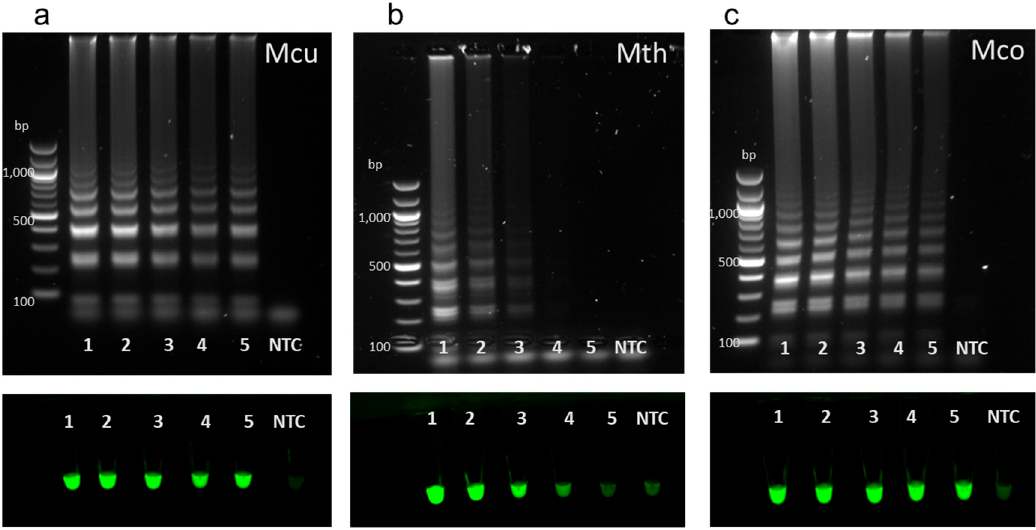
Figure 6. LAMP assay outputs comparing agarose gel electrophoresis (top panels) and Sybr Green I end-point detection (bottom panels). Genomic DNA from ( a ) Methanoculleus marisnigri JG1 (Mcu), ( b ) Methanothermobacter thermautotrophicus (Mth), and ( c ) Methanococcus maripaludis S1 (Mco) were added in decreasing quantities (lane 1: 10 ng, lane 2: 1 ng, lane 3: 100 pg, lane 4: 10 pg, lane 5: 1 pg) to genus-specific LAMP assays and compared to non-template controls (lane NTC) to determine assay sensitivity.